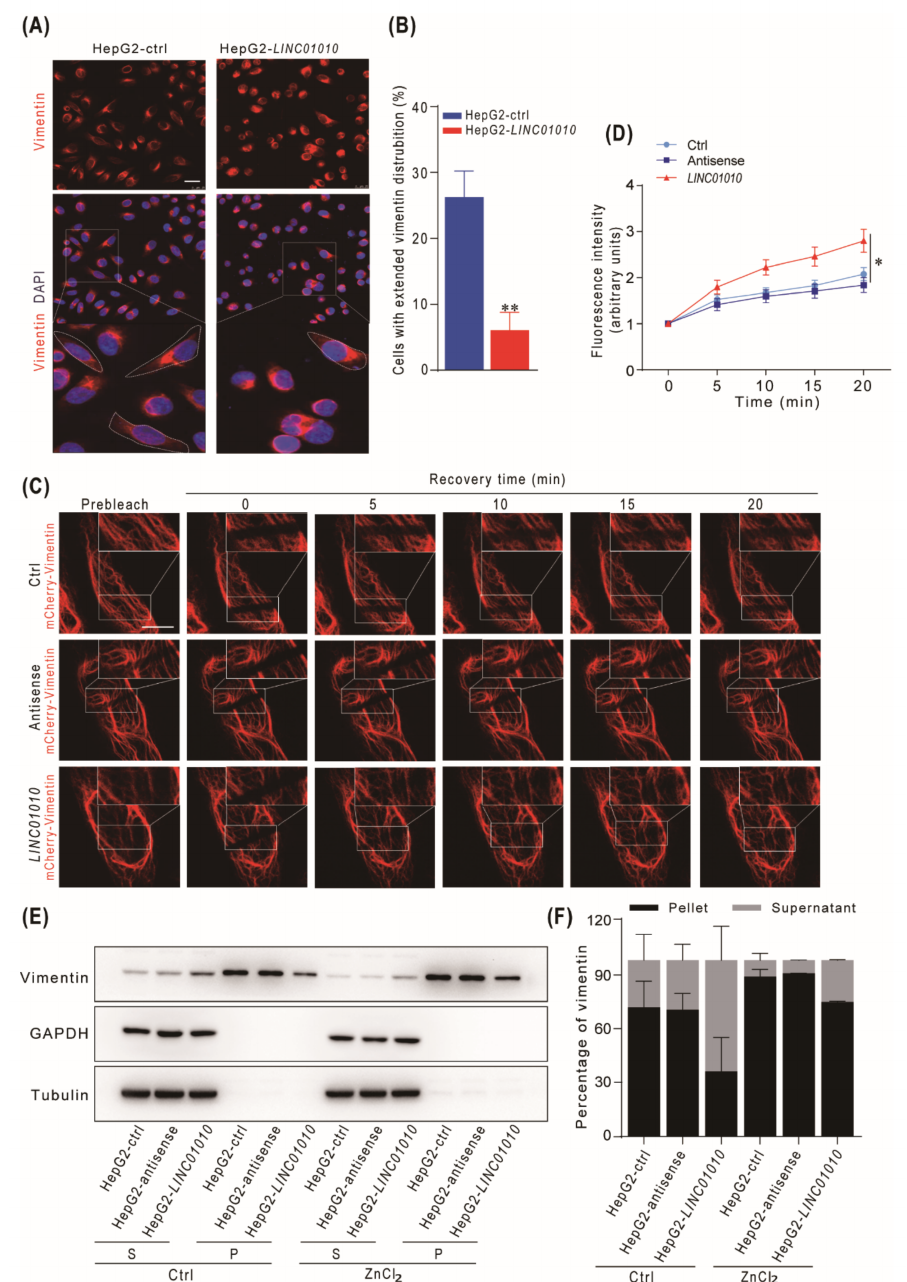
Figure 4. LINC01010 reduces the stability and formation of the vimentin network. ( A , B ) The HepG2 cells stably expressing LINC01010 and control cells were plated on cover glass for 4 h. The plated cells were fixed with 4% paraformaldehyde, followed by immunofluorescence assays with vimentin antibody. Red fluorescence (vimentin),DAPI staining (nuclei). The white dotted line indicates the cells with extended vimentin. Scale bars, 25 µ m ( A ). The percentage of cells with extended vimentin was calculated ( B ). ( C , D ) HepG2 cells were co-transfected with mCherry-vimentin and LINC01010 , antisense expression plasmids or control vector. Then, the cells were photo-bleached, and fluorescence recovery was monitored by acquiring images at time of 5, 10, 15 and 20 min after photo-bleaching with Leica SP8 confocal microscope. The white square indicates the photo-bleaching regions. Scale bars, 10 µ m ( C ). The fluorescence intensity of the bleached region at the different time points after quenching was measured by ImageJ software (Ctrl, n = 10; antisense, n = 10; LINC01010 , n = 10) ( D ). ( E , F ) HepG2- LINC01010 , HepG2-antisense or HepG2-ctrl cells were treated with and without ZnCl 2 (30 µ M) for 12 h. Then, the cell lysates were harvested and fractionated into supernatant (S) and pellet (P) and subjected to immunoblotting analysis. The relative density of vimentin was calculated (E). The percentage of soluble and insoluble vimentin was measured ( F ). * p < 0.05 and ** p < 0.01, means ± SD are